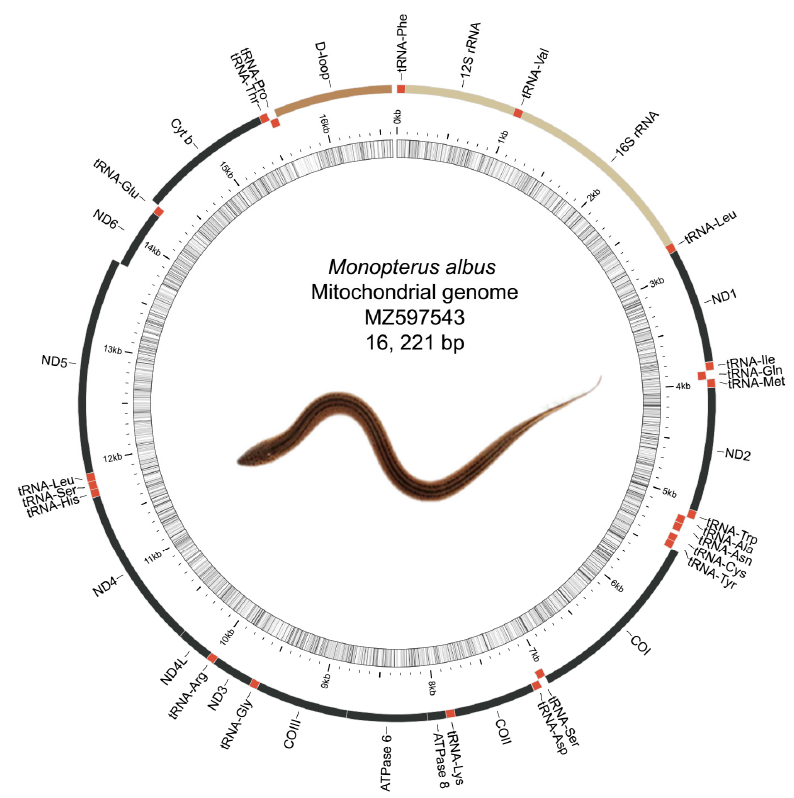
Figure 1. Mitochondrial genome map of M. albus breeding strain generated with MitoAnnotator. PCGs, rRNAs, tRNAs, and the D-loop are shown in different colors. Protein-coding genes are shown in black; tRNAs shown in red and designated by their three letter abbreviations. Light brown represents the rRNAs, while dark brown represents the D-loop. Genes located at the H- or L-strand are mapped outside or inside of the circle. The innermost circle of the images represents (G + C)% for every 5 bp of the mitogenome; the darker the line, the higher the (G + C)%. The length of the obtained mitogenome was 16,621 bp, which was only one nucleotide shorter than those five full mitogenomes reported previously [18,22]. The overall sequence similarity was in the range of 97–99%. The overall nucleotide composition was 28.92% A, 27.11% T, 14.50% C, and 29.47% G, with a slight A and T bias of 56.03%. This mitogenome consisted of 13 PCGs, 2 rRNAs, 22 tRNAs, and one putative control region (D-loop). Most of the genes were encoded on the H-strand, with only ND6 and eight tRNAs (Gln, Ala, Asn, Cys, Tyr, Ser, Glu, and Pro) located on the L-strand. The structural organization of this mitogenome conformed to the five previously reported ones for M. albus and the other teleost [22,42]. Ten protein-coding genes (ND1, ND2, COII, ATP8, ATP6, COIII, ND4L, ND5, ND6, and CYTB) had the ATG start codon, two protein-coding genes (COI, ND4) had the GTG start codon, and ND3 had ATA as the start codon. Three protein-coding genes (ND1,